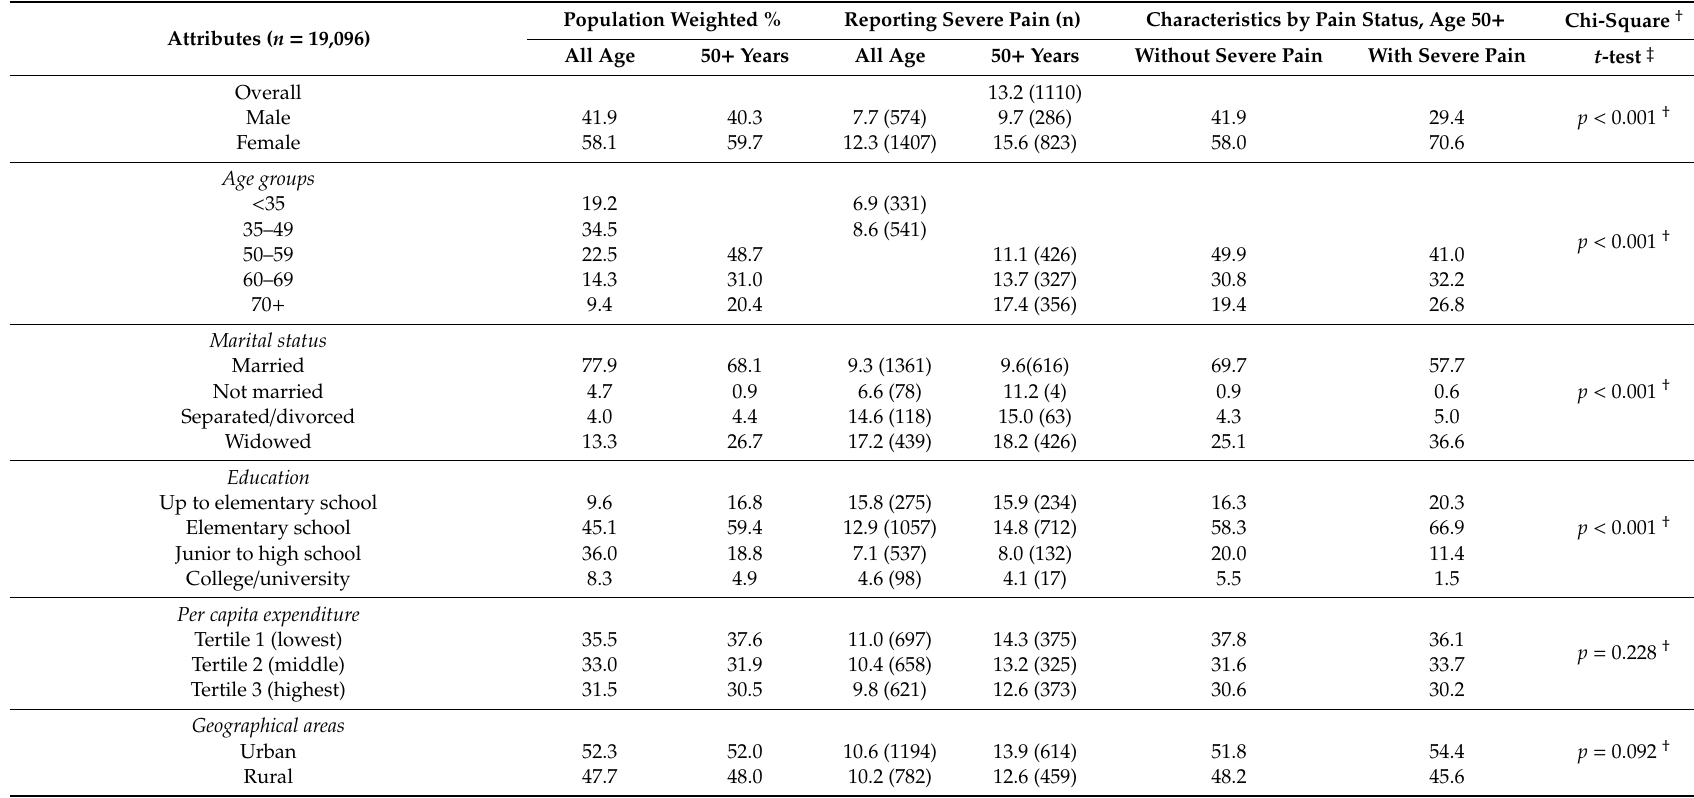
Table 1. Sample characteristics by pain level, Indonesian Family Life Survey (IFLS)